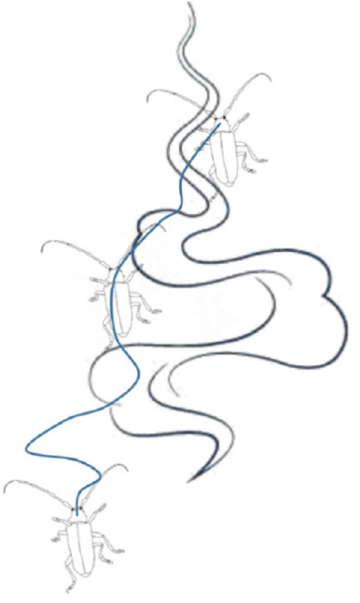
Figure 5. Bionic diagram of a